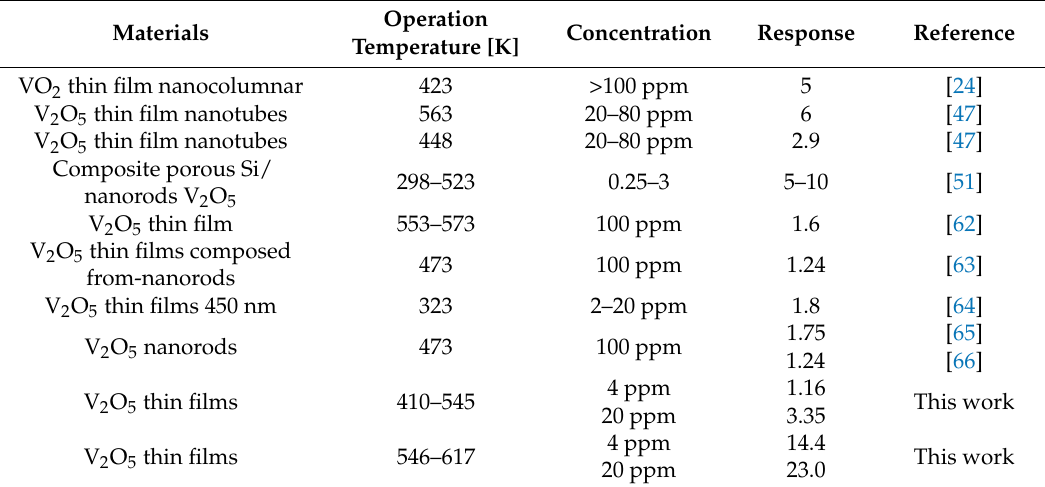
Table 2. Vanadium oxide-based semiconducting NO 2 sensors.